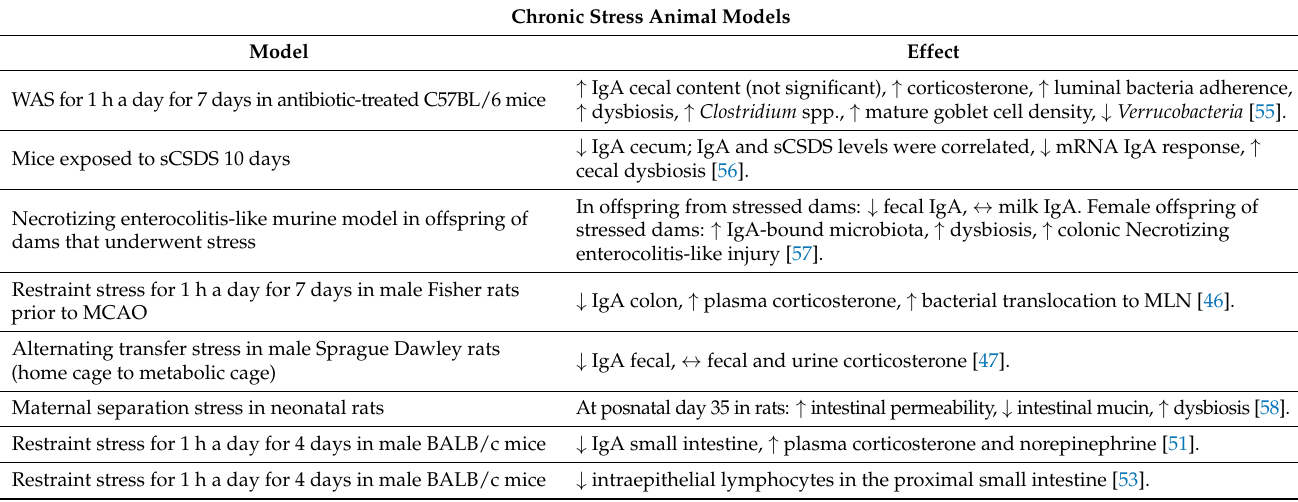
Table 1. Stress and gut barrier components (IgA and the mucus